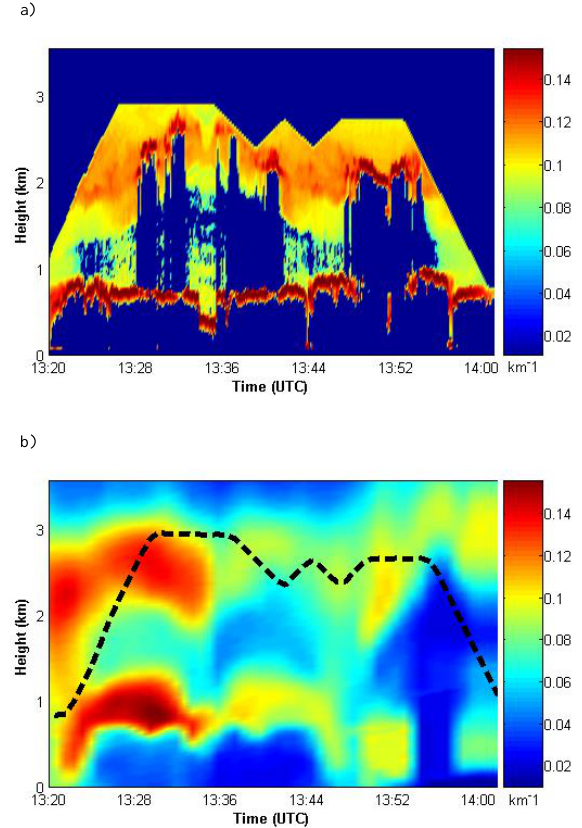
Figure 8. Vertical cross section of extinction coefficient (km − 1 ) (a) measured by LEANDRE and (b) simulated by Meso-NH over the Netherlands between (52.57 ◦ N, 6.34 ◦ E) and (51.88 ◦ N, 4.99 ◦ E) on 30 May 2008. The black line indicates the height of the aircraft. All the blue areas in the upper plot (LEANDRE observation) are areas without